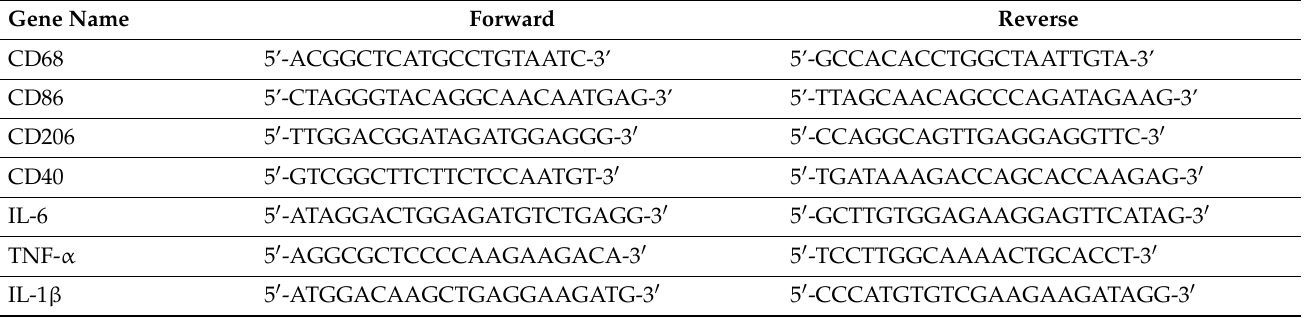
Table 2. Forward and reverse nucleotide sequences used for the gene of interest in a quantitative real-time polymerase chain reaction (qRT-PCR).